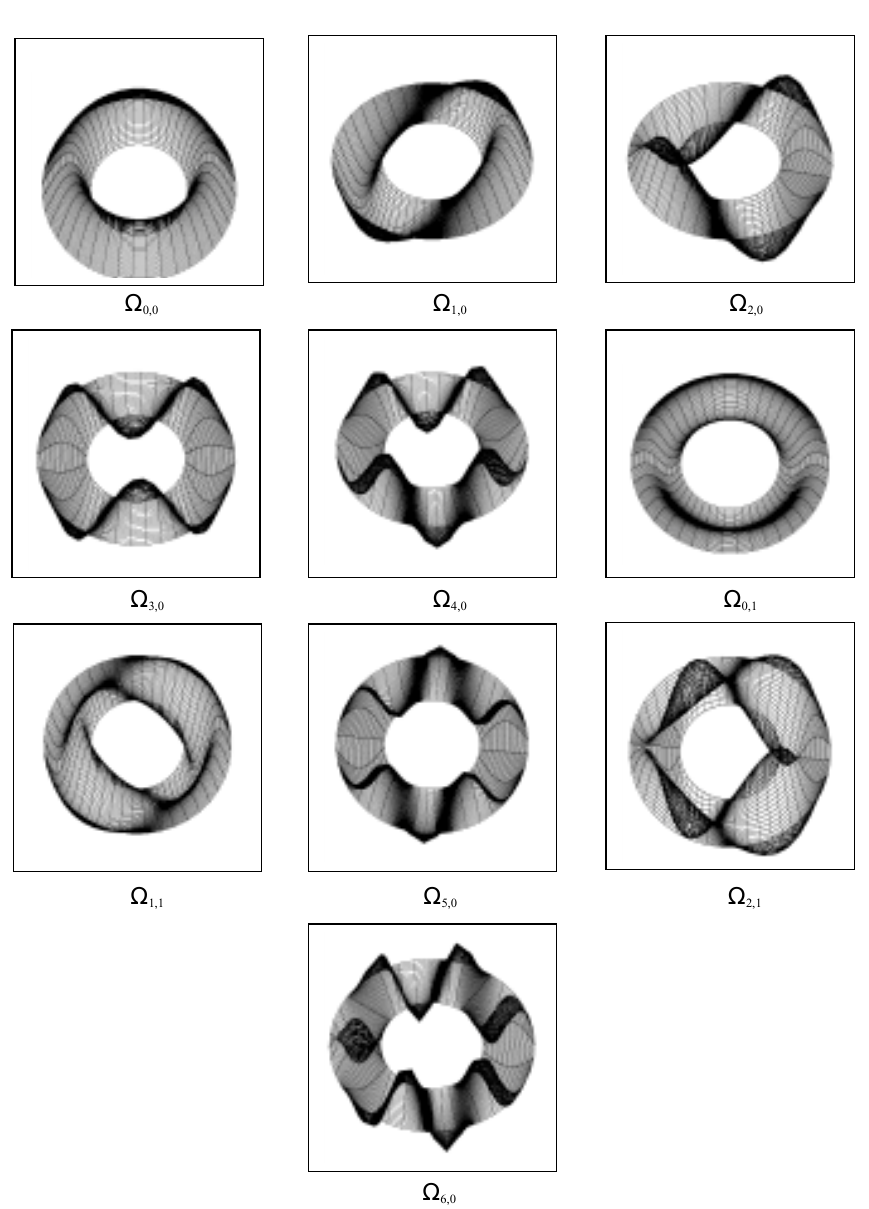
Fig. 7. Three dimensional plots for first ten normal modes of vibration for S - S plate when α = β = 0.4, e r = g r = 5.0, R 0 = 0.5, K f =